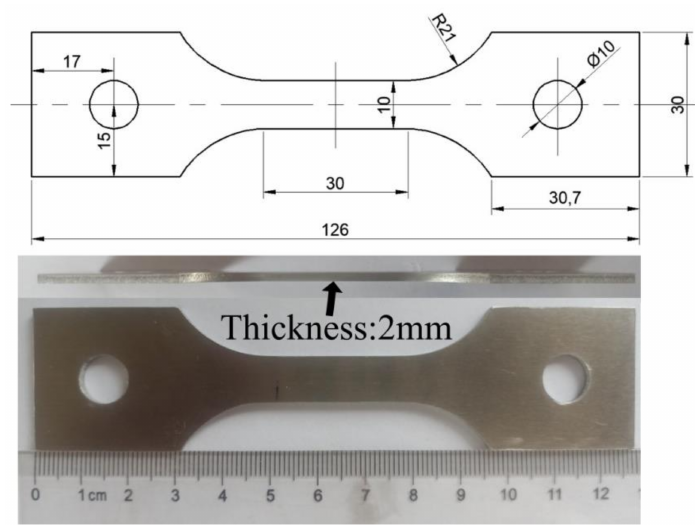
Figure 2. The shape and size of the